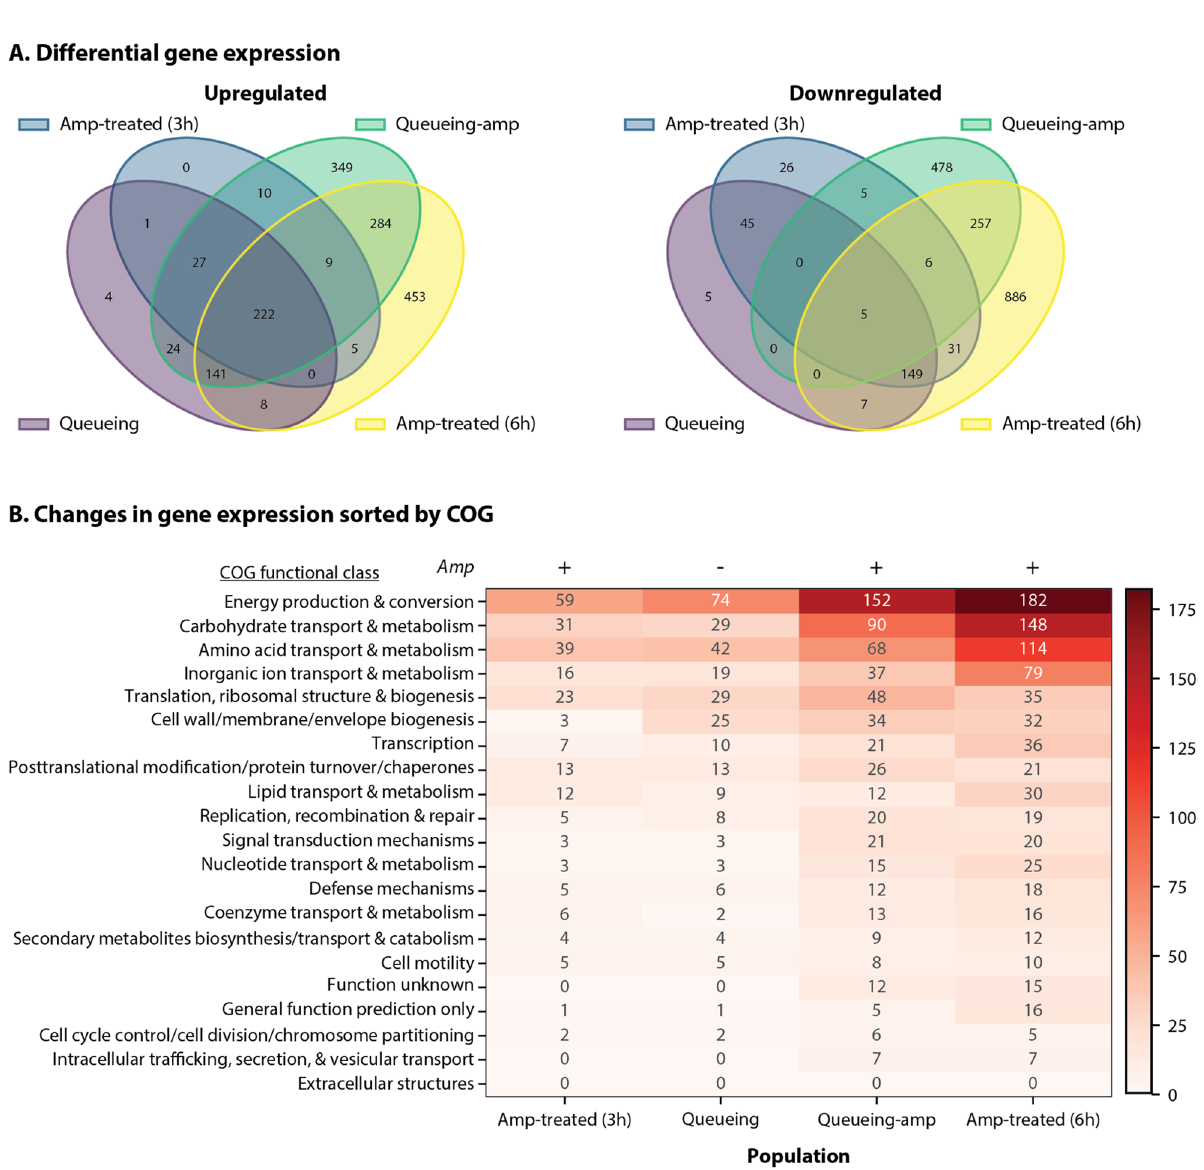
Figure 5. Proteolytic queueing and ampicillin treatment similarly affect gene expression in E. coli . Changes in gene expression compared to stationary phase (adjusted p < 0.1; with > twofold change) for each population with/without queueing (Q) and/or ampicillin (Amp). Not shown are changes in gene expression present in the untreated population. Cultures treated with ampicillin were treated for three hours (3 h) or six hours (6 h). ( A ) Venn diagram comparing each population. Left: Upregulated. Right: Downregulated ( B ) Changes in gene expression sorted in Clusters of Orthologous (COG) groups for each population. Genes in multiple categories were counted for each